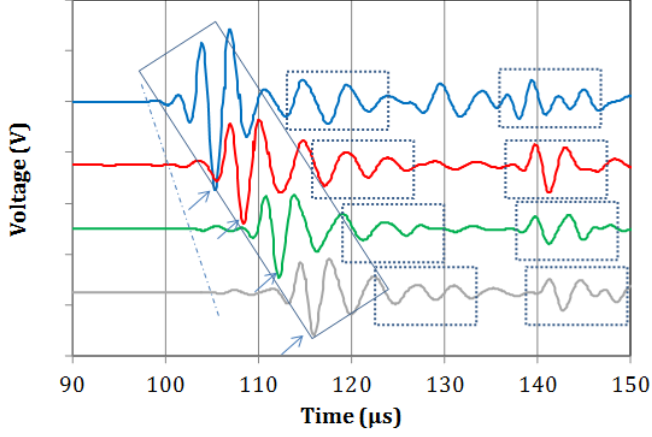
Figure 2. Elastic waveforms on the surface of bulk steel specimen.